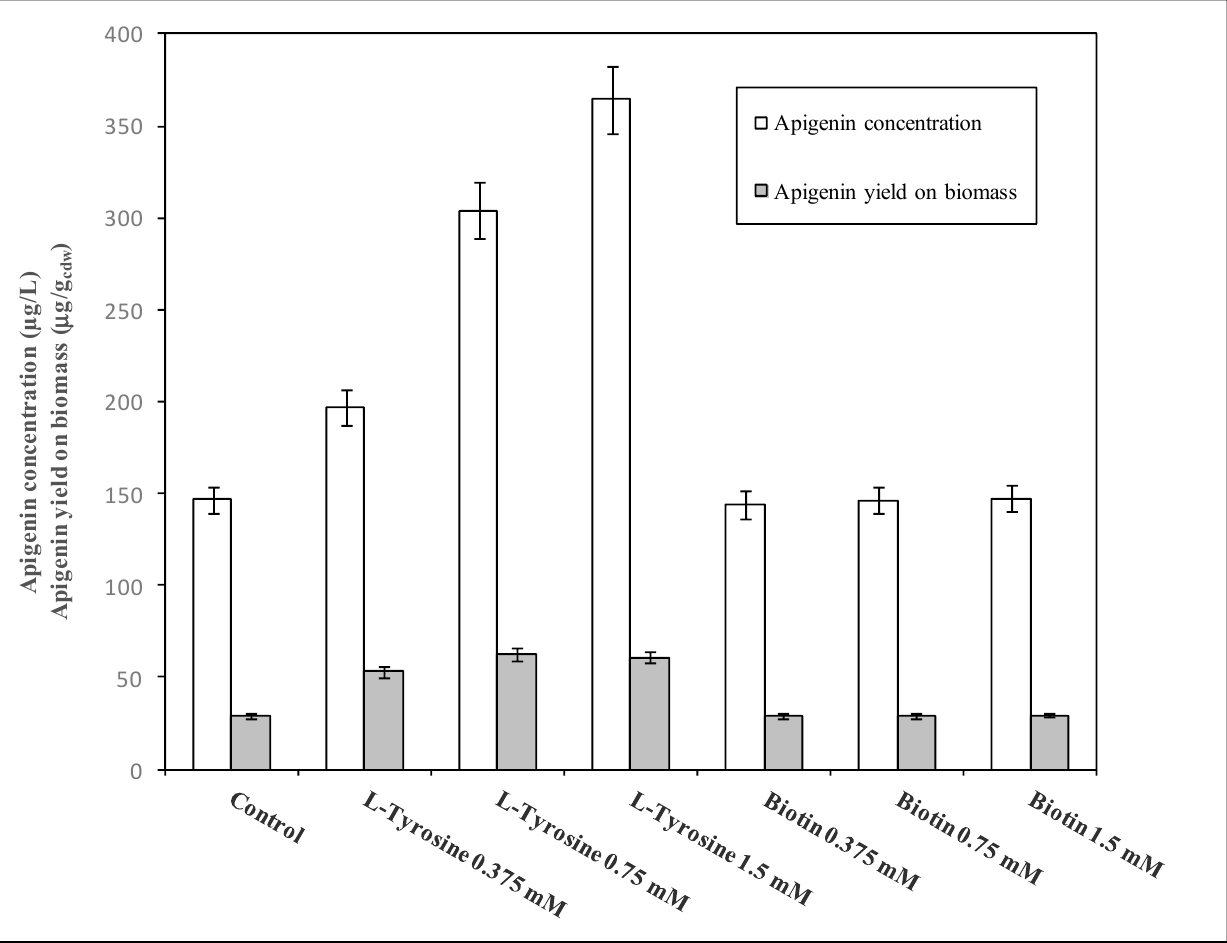
Figure 5. Shake flask experiments of Streptomyces albus- pAPI with supplementation of L-tyrosine and biotin as precursors, added at different concentrations: apigenin concentration and yield on biomass in comparison with the control.